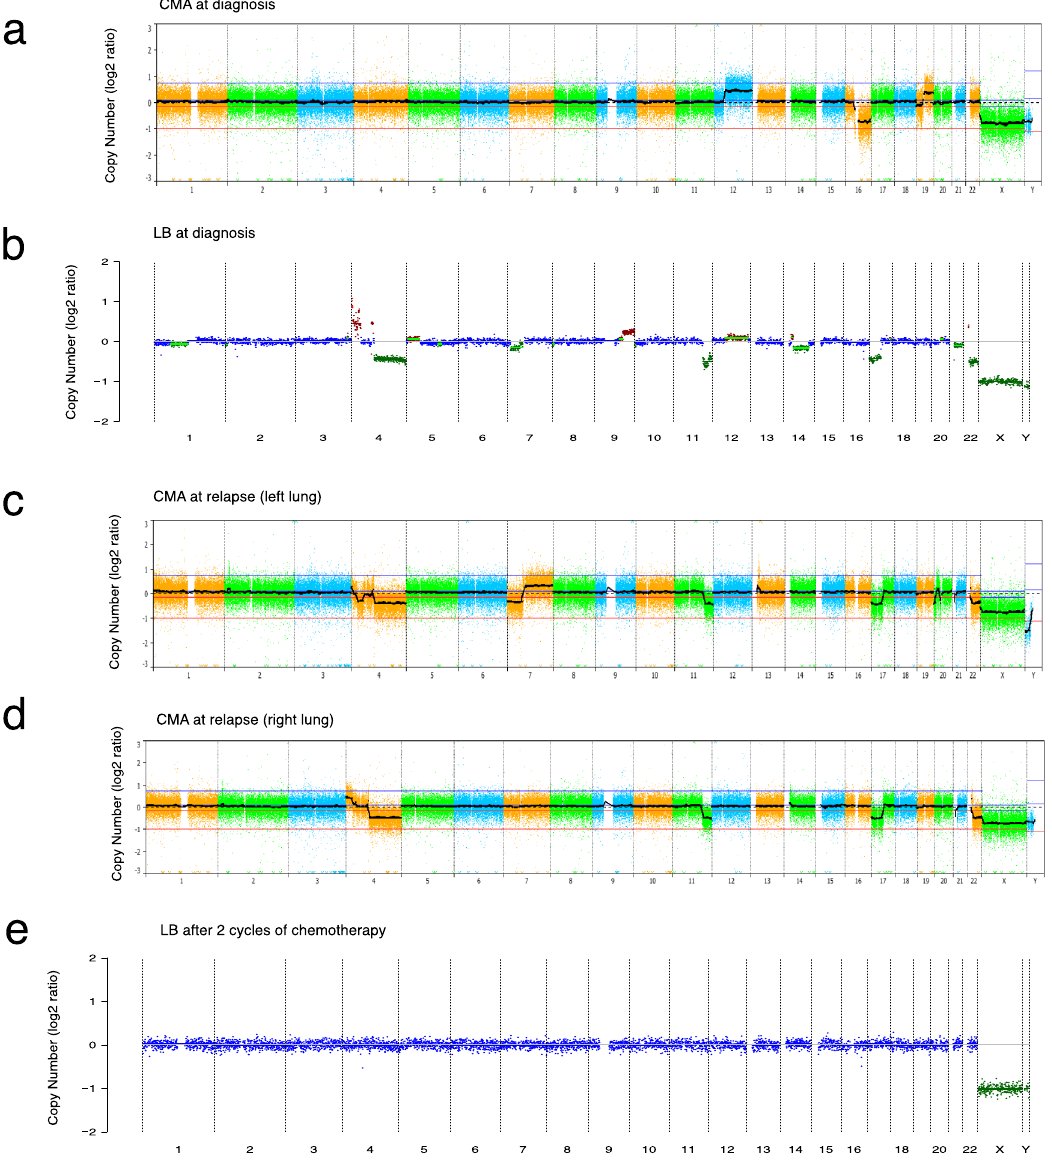
Fig. 2 Plasma CNA pro fi le of a patient with Wilms tumor mimics resected residual lung nodules following neoadjuvant chemotherapy. a Chromosomal microarray analysis (CMA) plot of the primary renal tumor resected at the time of diagnosis from a male patient with Stage IV anaplastic Wilms tumor (patient 56) demonstrates LOH for a region of the short arm of chromosome 11, a gain of 12q, loss of 16q; and gain of 19q. b CNA detection at baseline in the liquid biopsy sample reveals distinct copy number (CN) changes when compared to the primary tumor. Speci fi cally, chromosome 1p loss, 4p gain, 4q loss, 5p gain, 7p loss, 9q gain, 11q loss, 12q gain, 14q loss, 17p loss, and chromosomes 21 and 22 loss. The calculated tumor fraction (TFx) was 53%. c CMA pro fi le of CN changes from the residual lung nodules (left), and d (right) resected after two cycles of chemotherapy with chromosome 4p gain, 4q loss, 7q gain (left lung mass), 11q loss, 17p loss, chromosome 22 loss. e CNA pro fi le in the plasma after two cycles of chemotherapy showing a fl at pro fi le. The calculated TFx was 0%. For each serial LB sample, log2ratio is plotted on the y-axis against chromosome numbers 1-22, X, Y. Red indicates CN gain, blue indicates CN neutral, and green indicates CN fi les and con fi rmed the presence of the variant allele by visual suggesting clonal expansion and evolution of the disease. This increase in VAF was also correlated with an increase in tumor inspection using IGV. A total of 16 pathogenic or likely pathogenic purity estimates using ichorCNA, suggesting that mutations mutations identi fi ed by OncoKids ® were identi fi ed for 14 of our detected by LP-WGS could provide an alternative approach for patients using the LP-WGS data (Fig. 5a). One germ cell tumor monitoring clonal dynamics. Similarly, the tumor sample from a (patient 69), described above, was pro fi led with our OncoKids ® patient with metastatic osteosarcoma (patient 11) was positive for NGS-panel and had a con fi rmed KRAS mutation, c.182 A > G (Fig. a TP53 missense (c.743 G > A) variant of strong clinical signi fi cance, 5b). We were able to detect this mutation by LP-WGS in the at a VAF of 28%. Mutational analysis of LP-WGS data allowed us to plasma LB which revealed a similar variant allele frequency (VAF) detect this same mutation at a VAF of 33%. TP53 and KRAS were as reported by OncoKids ® , albeit at 4.4x depth of coverage. The among the most mutated genes identi fi ed from both the LP-WGS VAF increased from 12 to 73% in the cfDNA during progression